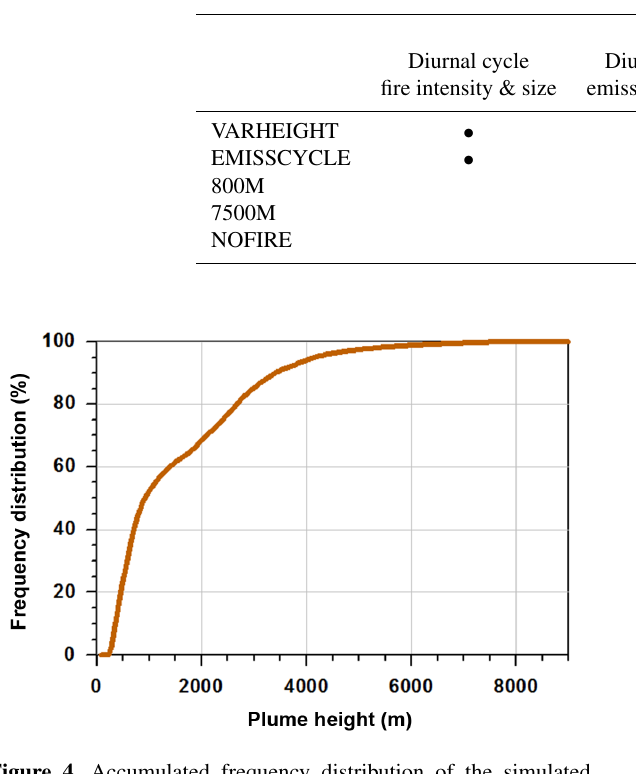
Figure 4. Accumulated frequency distribution of the simulated plume heights for the 10-day time period from 10 to 20 July 2010. In total 52628 data points are included.